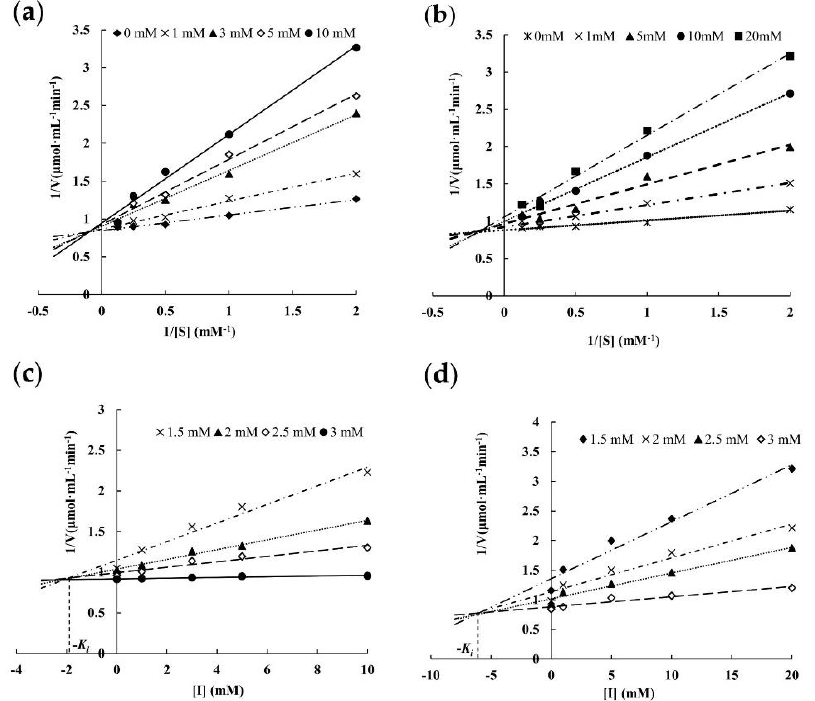
Figure 6. Inhibition kinetics assays of ORG. Lineweaver–Burk plot for determining the inhibition mode of ( a ) melibiose (0 − 10 mM) and ( b ) galactose (0 − 20 mM); Dixon plot for determination of inhibition constant Ki of melibiose ( c ) and galactose ( d ) at different p NPG concentrations (1.5 − 3 mM).